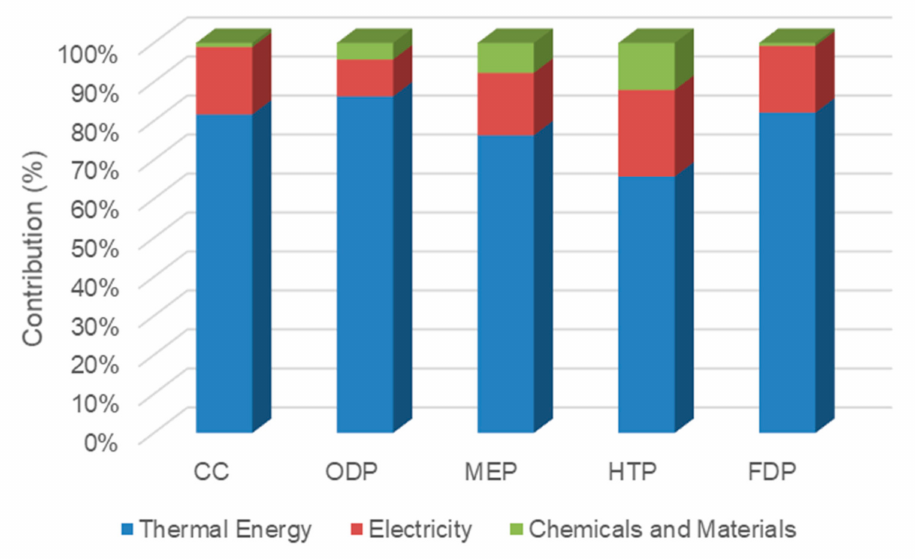
Figure 7. The contribution of inventories in midpoint impacts of case 1.